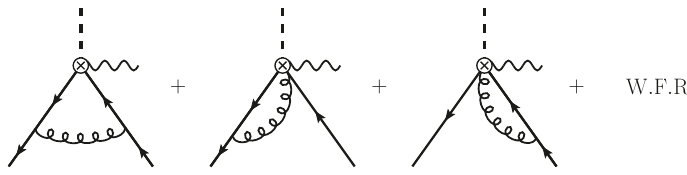
Figure 6 . One-loop diagrams contributing to the calculation of the diagonal renormalization factor Z 22 . In the second and third graph the gluon is emitted from the Wilson lines contained